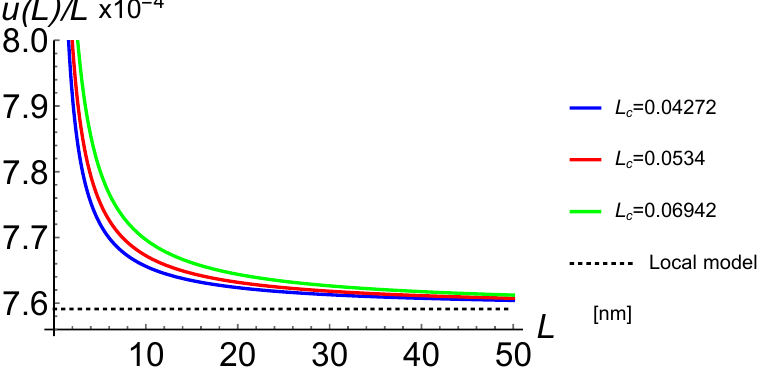
Figure 5. SWCNT of armchair (10, 10) having diameter d = 1.356 nm, effective thickness t = 0.34 nm and classical (local) Young’s modulus E = 909.5 GPa simulated by a CF nano-rod with a concentrated load F = 1 nN at the free end. Plot of the non-dimensional maximum displacement u ( L ) / L of the NSG model vs. the SWCNT’s length L for the nonlocal parameter L c ranging in the set { 0.04272,0.0534,0.06942 } nm. The non-dimensional local maximum displacement (black dotted line) is 1/ A E = 7.59117 × 10 − 4